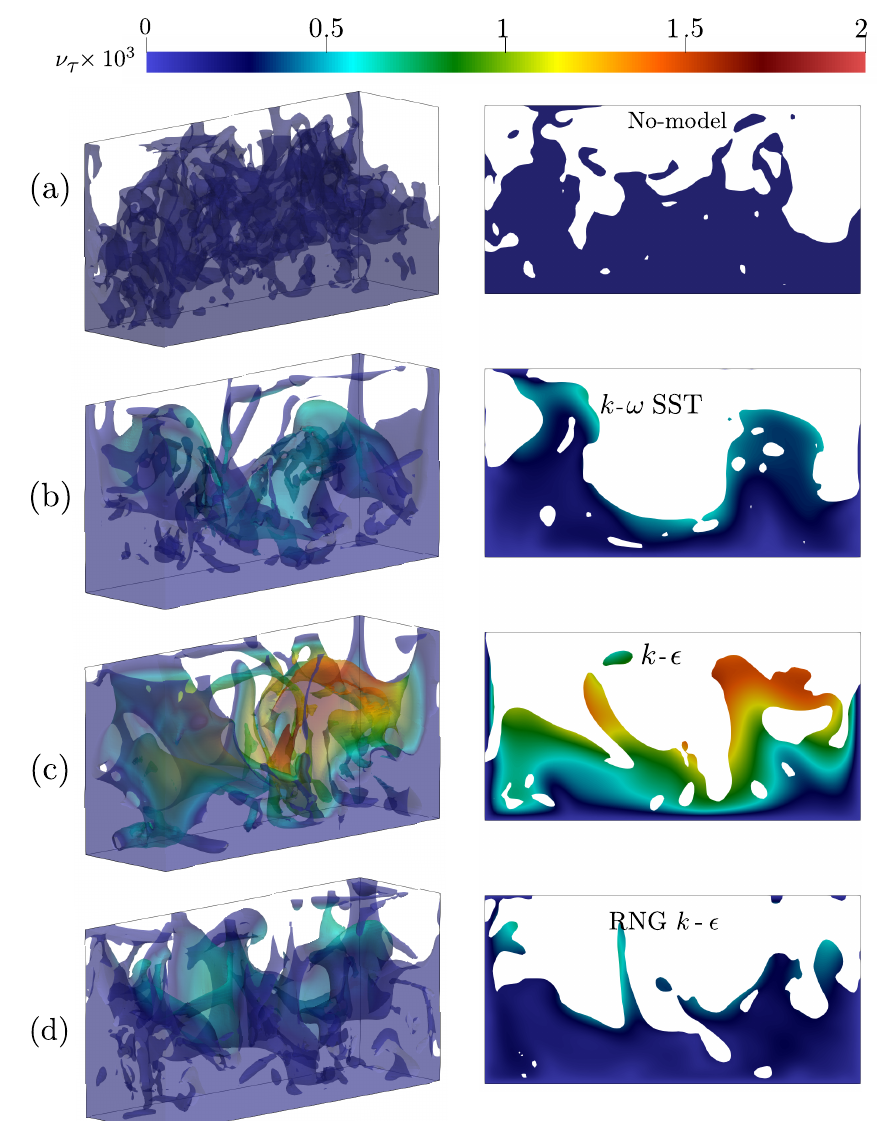
Figure 8. Snapshots of the liquid volume ration α > = 0.5 obtained by different turbulent models, and the right figures are two-dimensional slices in the middle plane of the left figures. The colouring scheme is the turbulent viscosity, and the opacity is reduced to 50% to show the internal